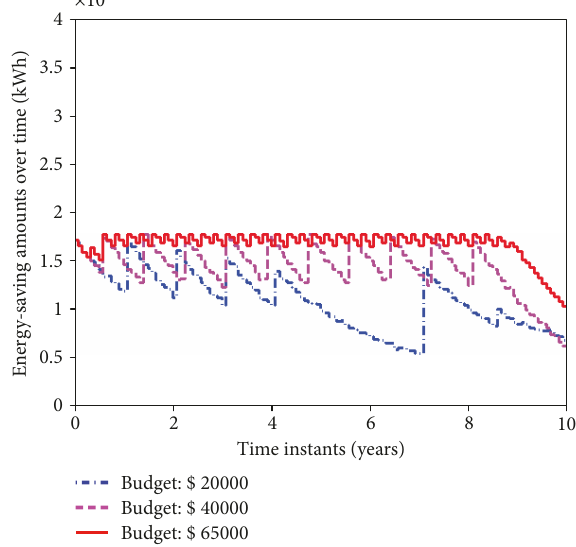
Figure 3: Energy saving trajectories of the optimal time schedule and maintenance plan with di ff erent maintenance